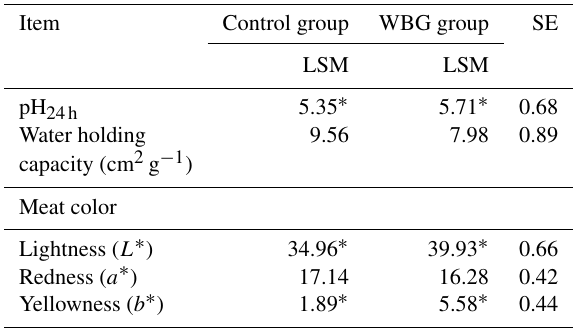
Table 5. The meat quality traits of the control and WBG lambs.